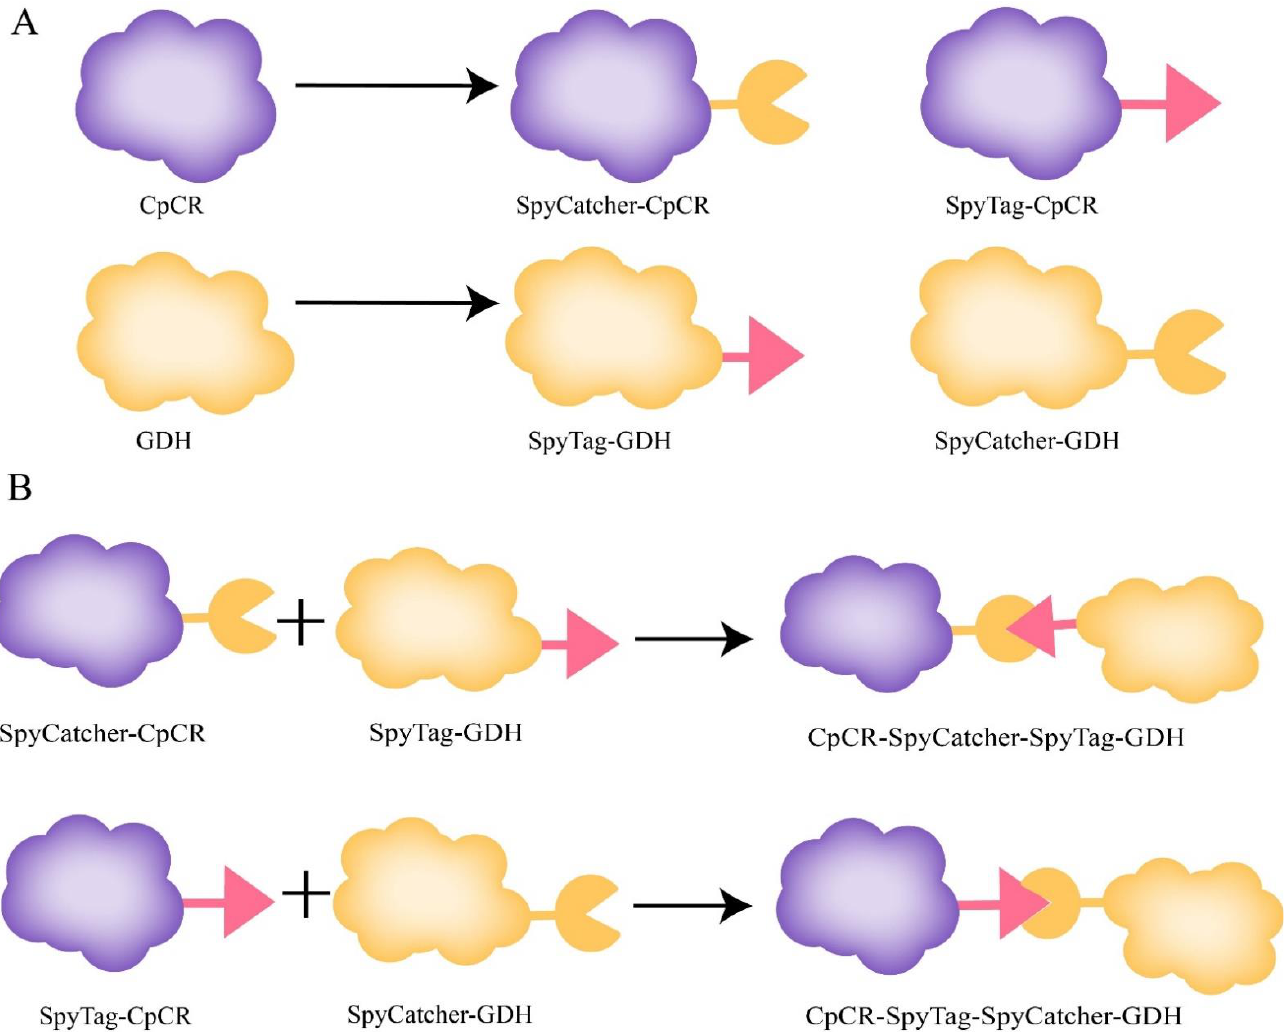
Figure 5. Spontaneous reaction between SpyCatcher- and SpyTag-fusion enzymes. ( A ) Six fusion enzymes. ( B ) Schematic diagram of spontaneous covalent reaction between purified target enzymes.